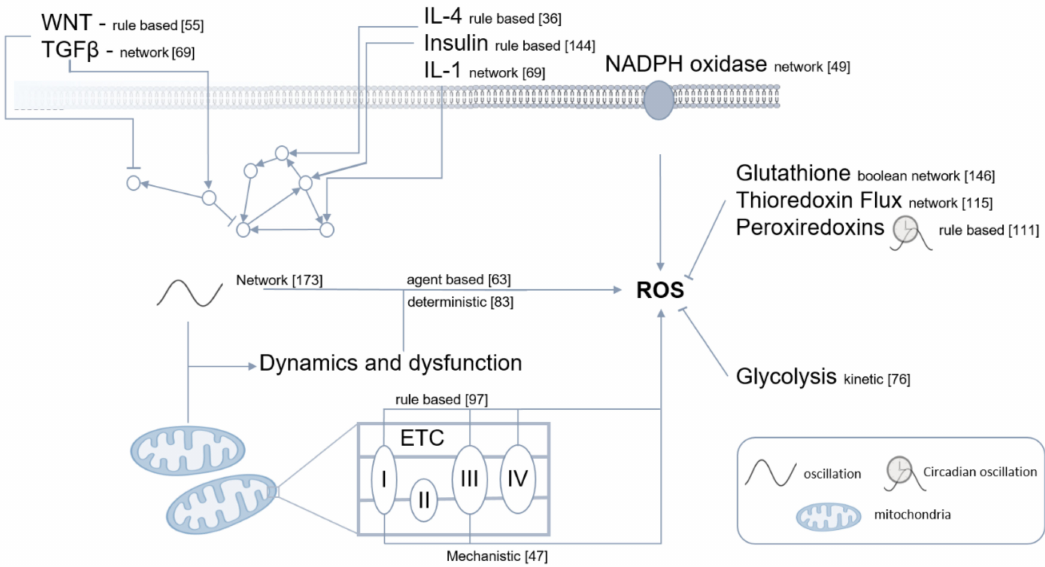
Figure 5. Interacting redox-sensitive pathways with existing computational models. The gener- alized model type is named, including a model reference. Detailed information can be found in Supplementary Material